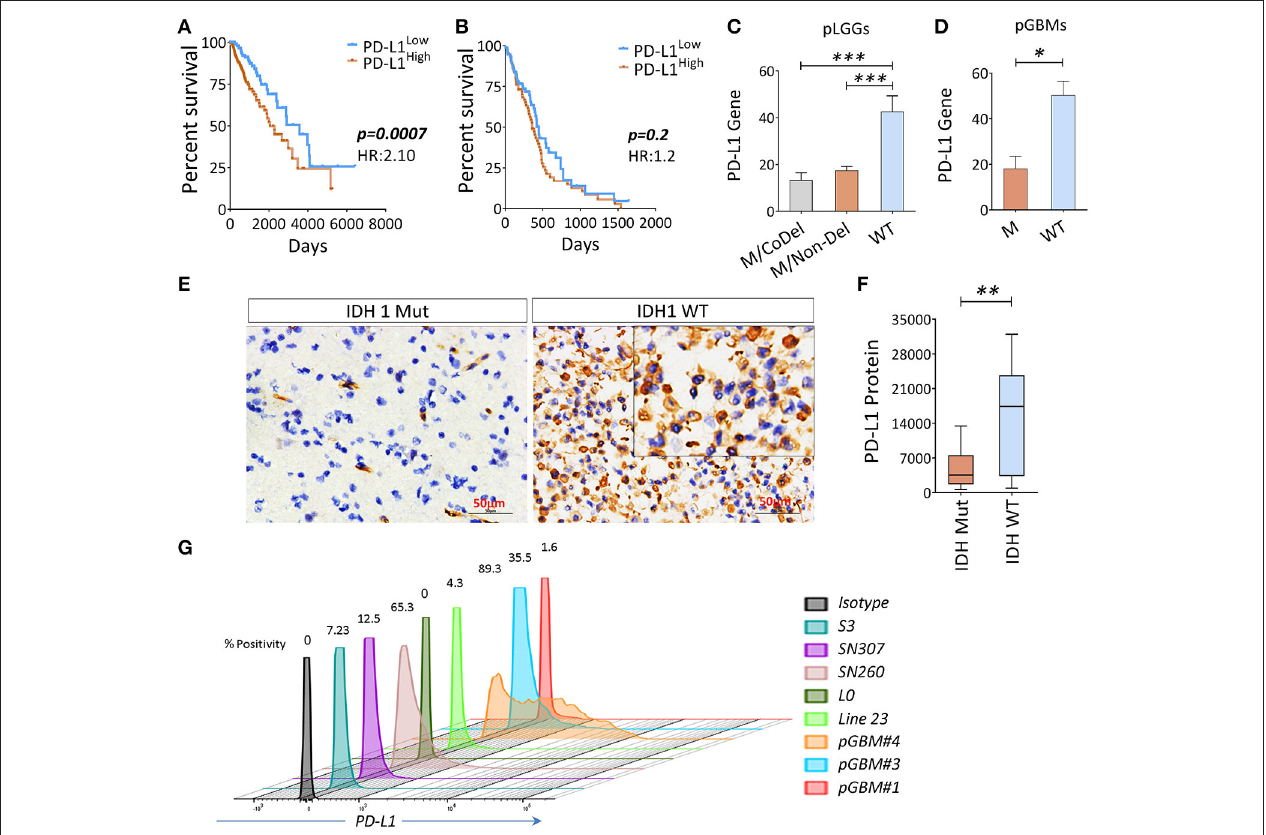
FIGURE 4 | The association between PD-L1 gene expression (PD-L1) and OS in gliomas and wildtype tumors expressed a higher level of PD-L1. (A) The PD-L1 expression is inversely correlated with OS in pLGGs; (B) no similar trend was found in pGBMs. The RNAseq data of 282 primary LGGs and 151 primary GBMs with IDH mutation status and patients’ OS culled from TCGA were analyzed. Median values were used as a cut-off point in each comparison. The Kaplan–Meier survival curves and the log-rank test were used to compare the groups in terms of OS and hazard ratios (HRs). (C,D) PD-L1 gene and PD-L1 expression among three LGG subgroups, as well as GBM with (WT) or without (M) IDH mutation. (E,F) IHC staining of PD-L1. Surgically resected tumors of mutant ( n = 13) or wildtype ( n = 14) LGGs were stained with a PD-L1 antibody; the quantitation of PD-L1 was analyzed using Image Plus Premier 9.1 software. (G) The PD-L1 expression on primary glioma lines; the PD-L1 expression on these cell lines was determined by FACS analysis and positivity was calculated using the isotype as a control. The difference between the two groups was analyzed using the Mann–Whitney U